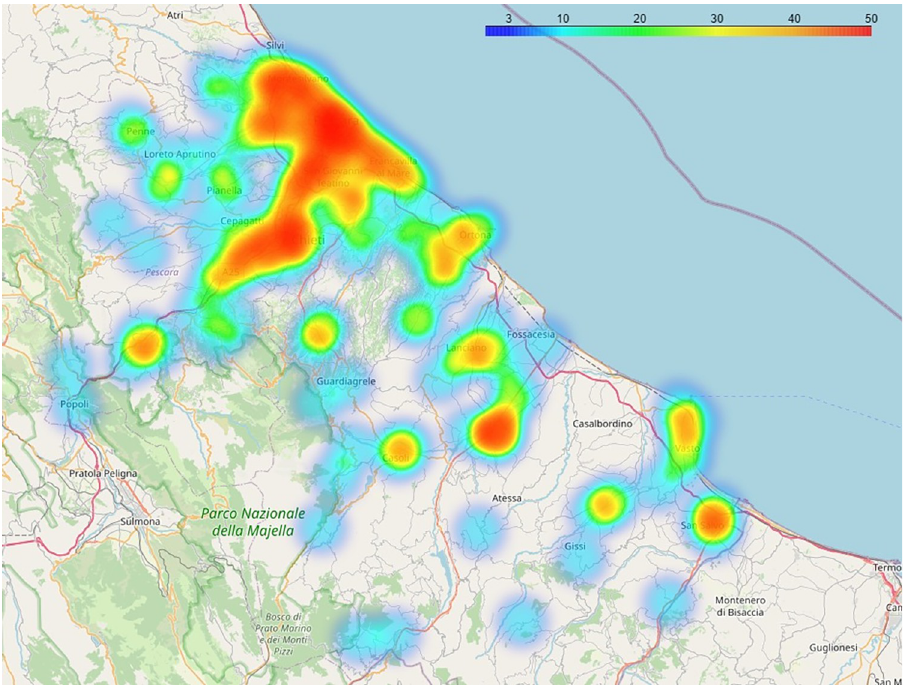
Fig 1. The localization of the innovative firms in the provinces of Chieti and Pescara. Heatmap based on the number of firms. Basemap: